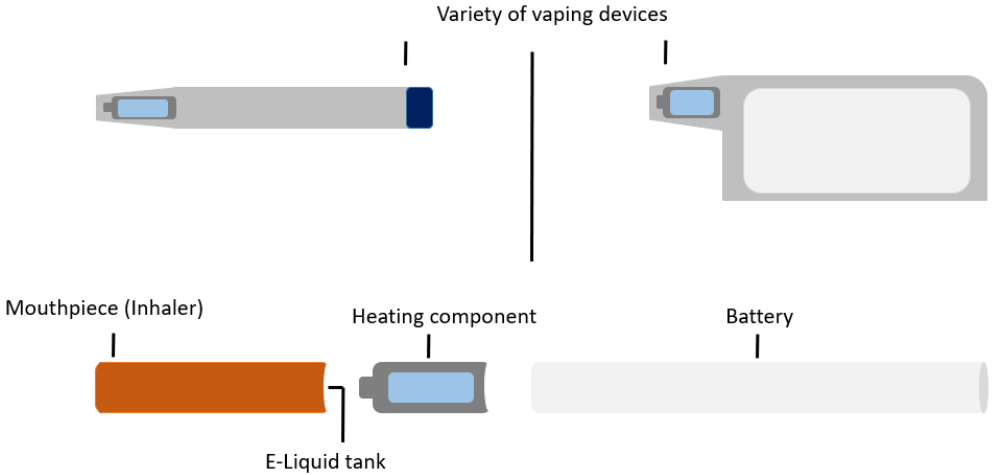
Figure 1. E-cigarette or vaping device.